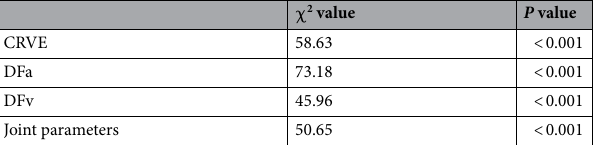
Table 5. Detection rate of retinal vascular geometry compared to VPT. VPT Vibration perception threshold, CRVE Central retinal vein equivalent, DFa Fractal dimension arterioles, DFv Fractal dimension veins.